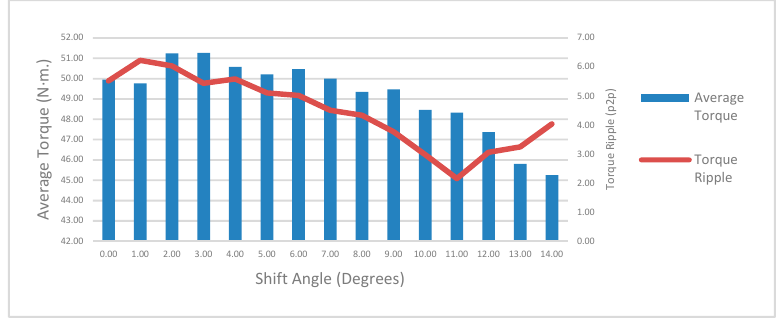
Figure 8. Defining the shifting angle by 3D-FEA parametric analysis.